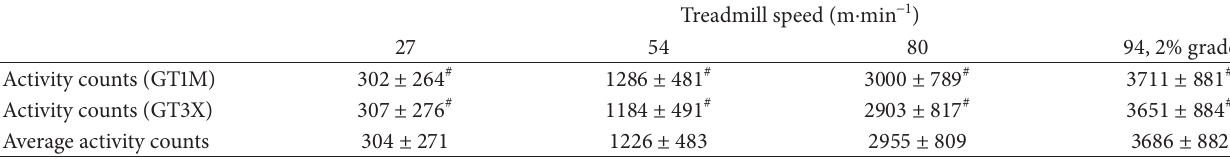
Table 2: Activity counts (counts ⋅ min − 1 ) during treadmill walking from uniaxial (GT1M) and triaxial (GT3X) accelerometers ( 𝑛 = 32 ).